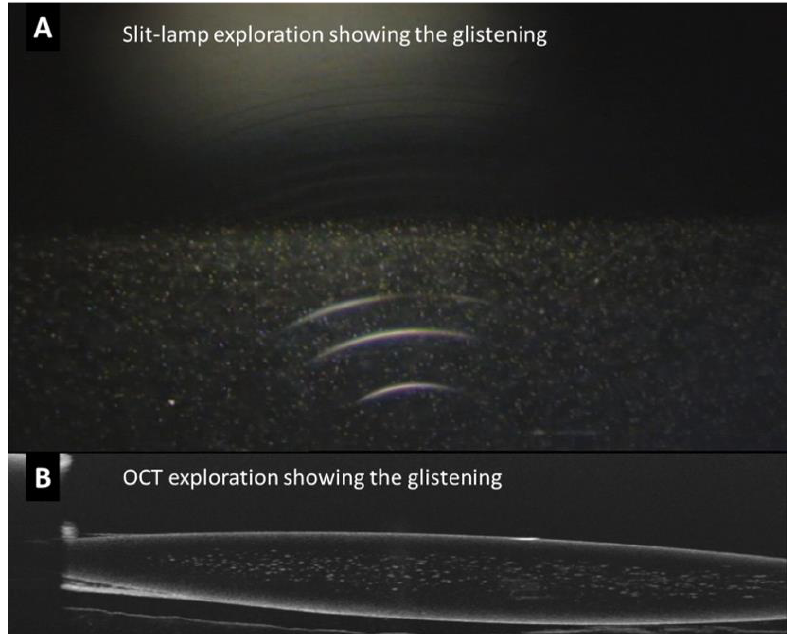
Figure 1. Example of an intraocular lens (IOL) with a high number of hyperreflective foci or mi- crovacuoles in the optic of the lens viewed through slit-lamp photography ( A ) and optical coherence tomography (OCT) ( B ).